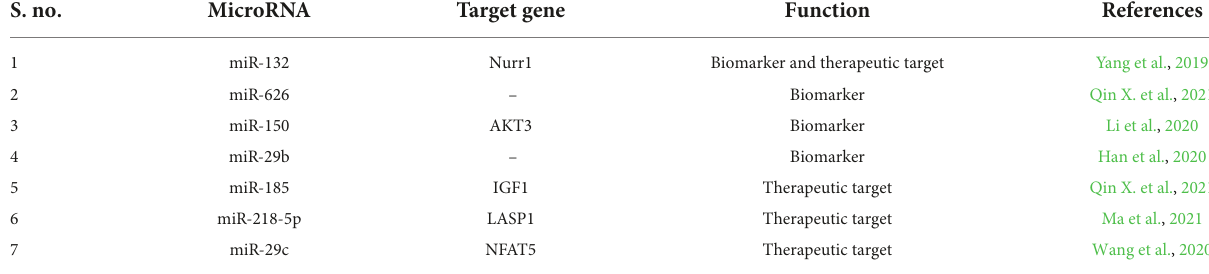
TABLE 2 miRNAs as biomarkers and therapeutic targets in Parkinson’s disease. S.